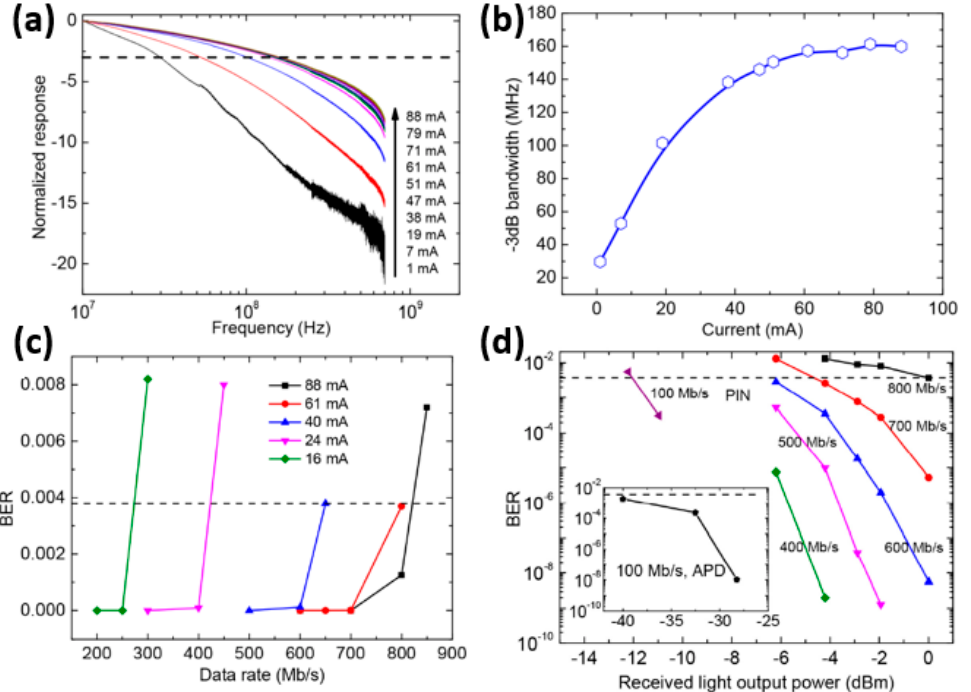
Figure 12. ( a ) Frequency response of the micro-LED at different injected currents; ( b ) -3dB modulation bandwidth as a function of current; ( c ) BER vs. data rate; (d) BER vs. received light output power. [89] Figures reproduced with permission from Optical Society of America.